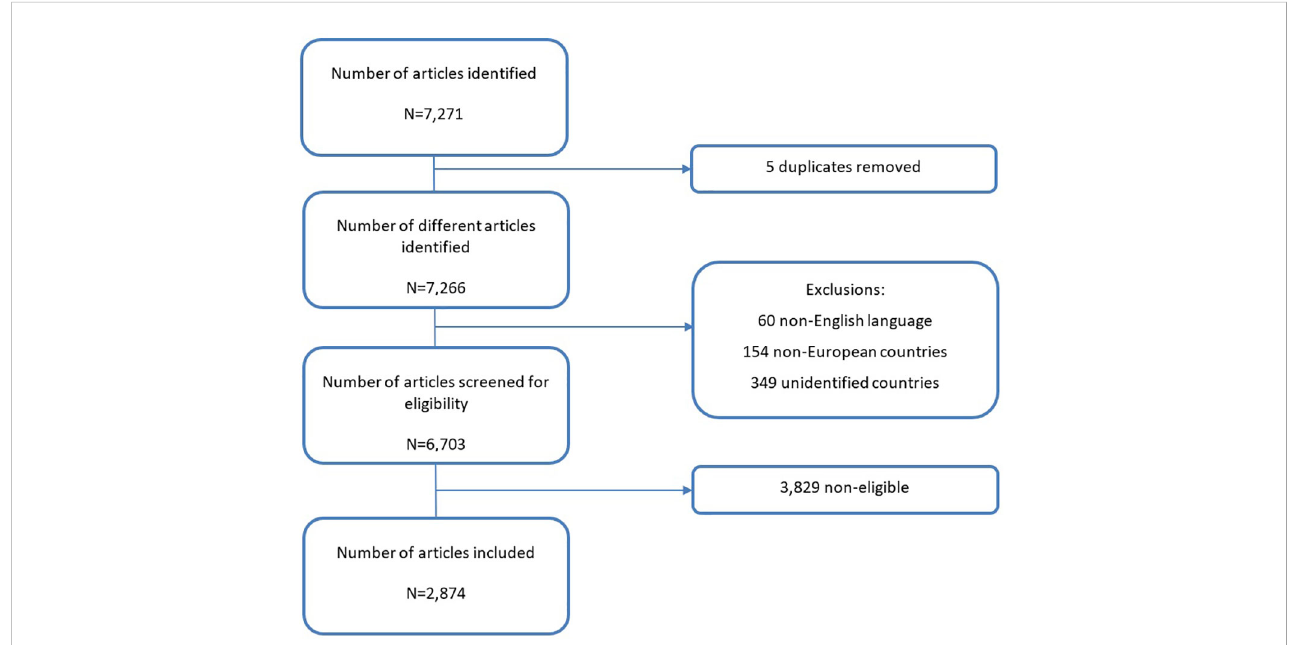
FIGURE 1 Flowchart of the identi fi cation, screening and eligibility of articles included in the literature